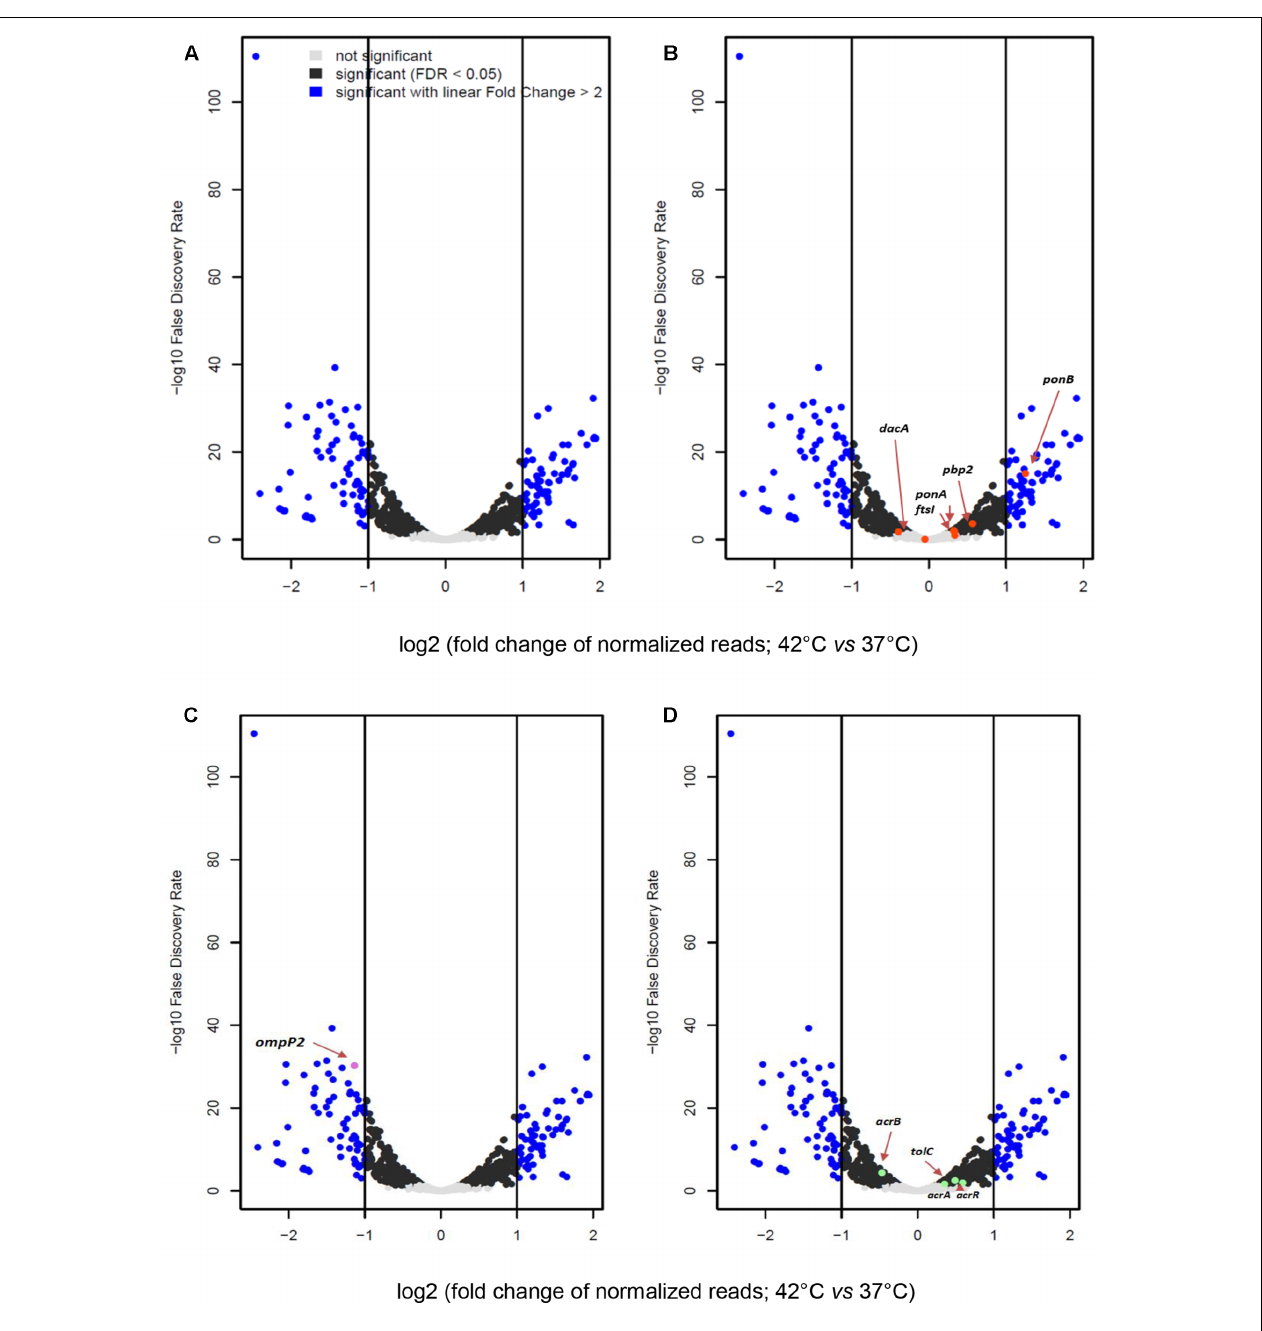
FIGURE 6 | (A) Volcano plot reporting the –log10 false discovery rate (FDR) versus the log2 transformed fold change in read counts between 37 and 42 ◦ C. Each dot represents a given gene. Fold change is computed by considering the expression level at 42 ◦ C compared to 37 ◦ C, thereby all genes at the right of 0 of x-values are meant to be up-regulated at 42 ◦ C and those at the left of 0 of x-values are down-regulated at 42 ◦ C. Gray = genes that do not change in significantly expression; black = genes with expression values associated with FDR-corrected p -values; blue = genes expression values associated with p -value < 0.05 and linear fold change between 37 and 42 ◦ C higher than 2. (B–D) Same as (A) except that in (B) genes coding for PBPs are marked in red; in (C) outer membrane protein P2 gene is in violet, (D) efflux pumps (AcrAB-TolC) and the repressor AcrR-coding genes are depicted in green. ponA gene encoding PBP1a; ponB gene encoding PBP1b; pbp2 gene encoding PBP2 ; ftsI gene encoding PBP3 ; dacA gene encoding